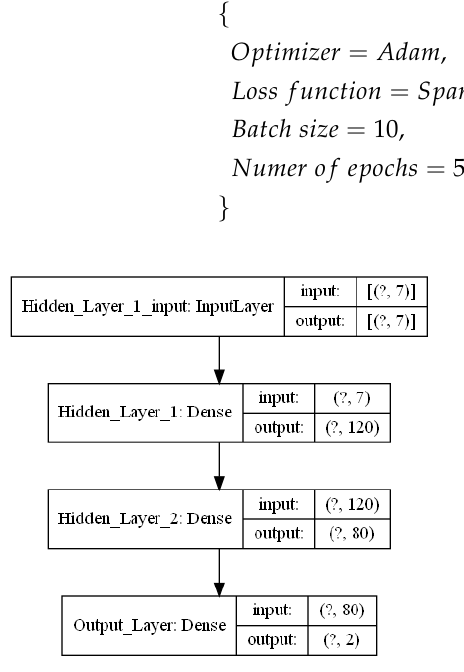
Figure 8. Architecture of the model.